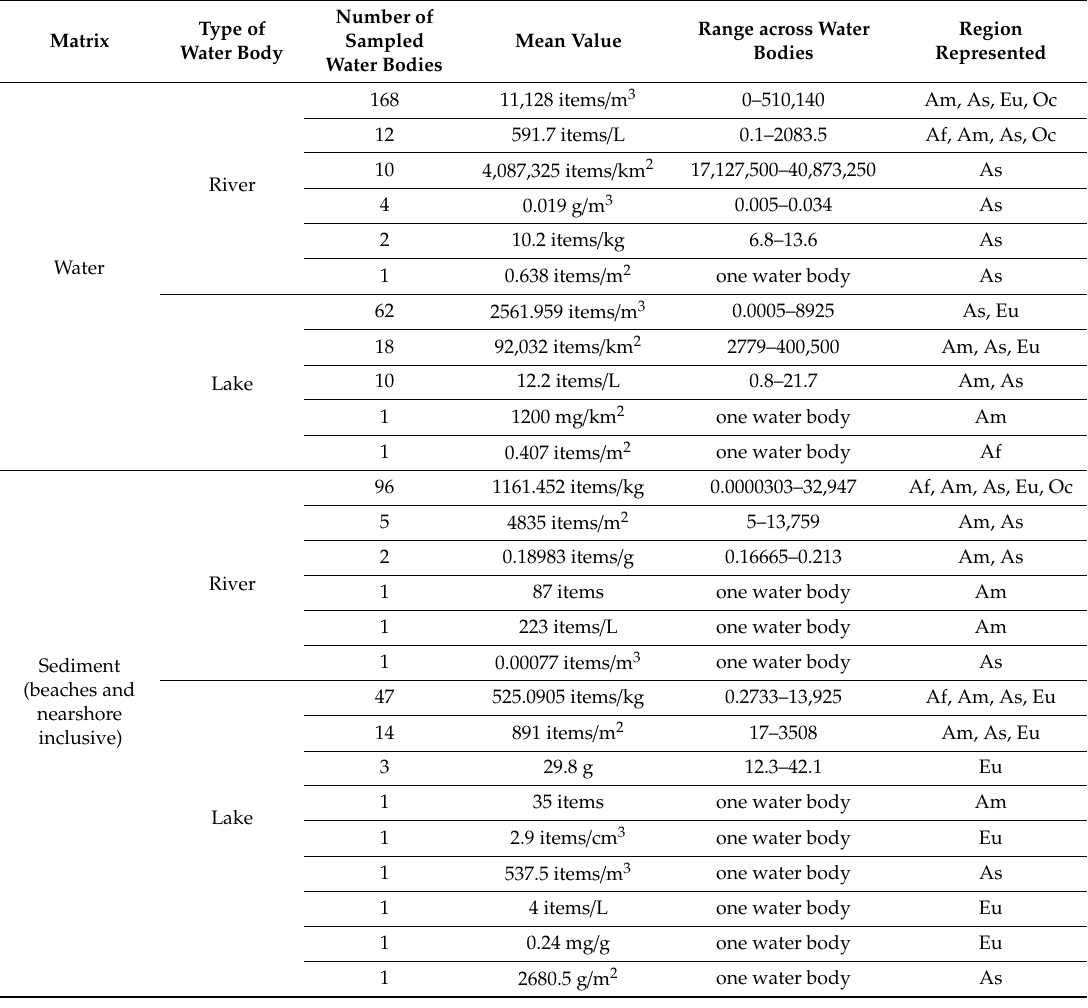
Table 1. Average concentration of fMPs depending on units of measurement. Af: Africa; Am: America; As: Asia; Eu: Europe; Oc: Oceania. For references, see Tables S2 and